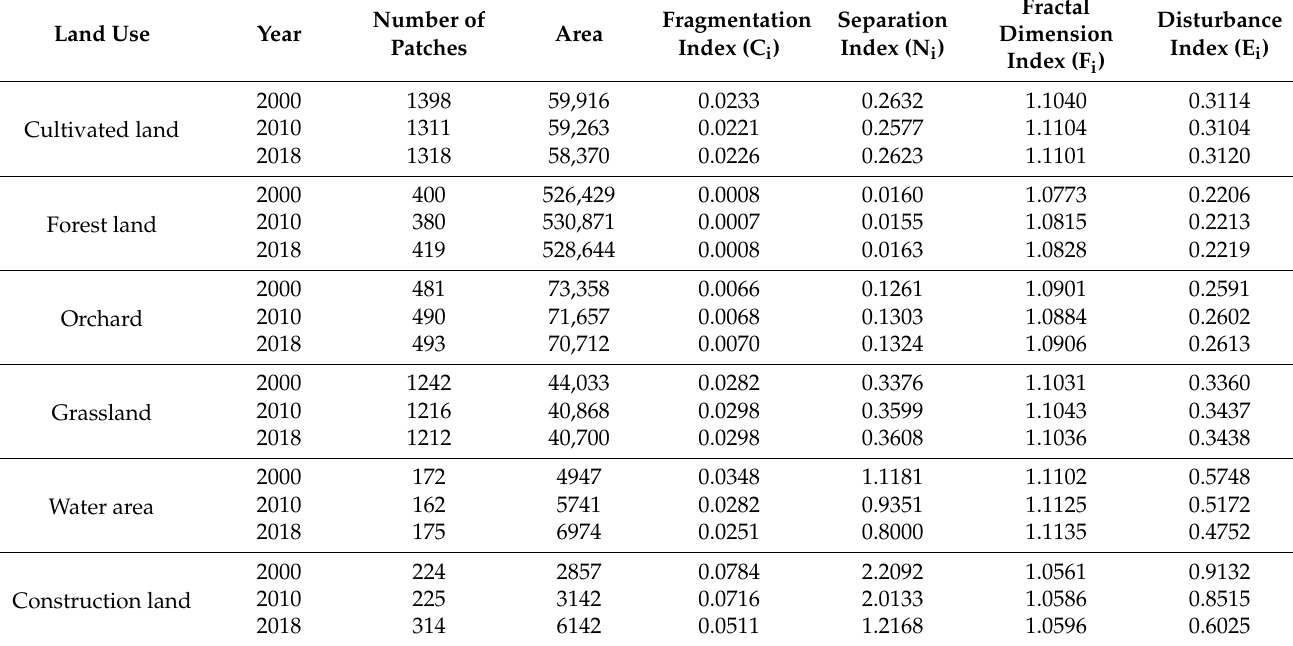
Table 4. The results of landscape pattern